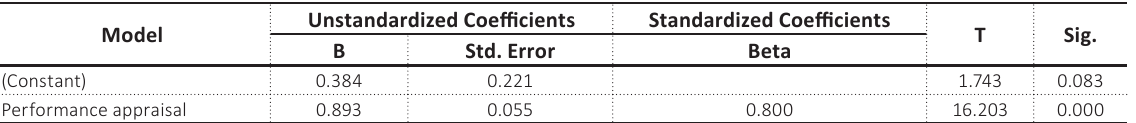
Table 14. Regression coefficients for